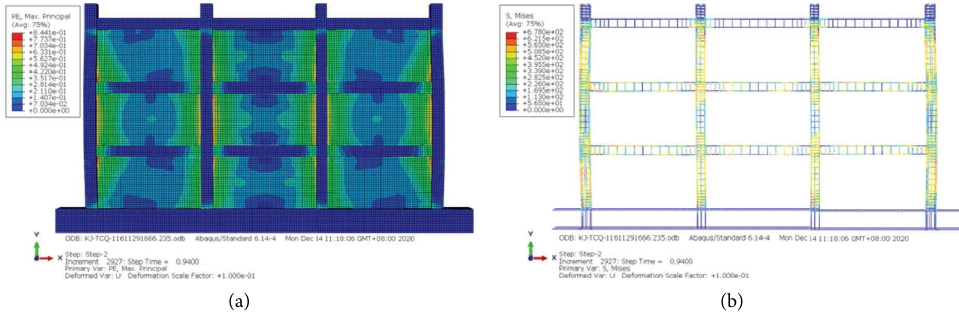
Figure 16: Specimen KJ-T-1. (a) Concrete plastic strain contour. (b) Steel bar stress contour.